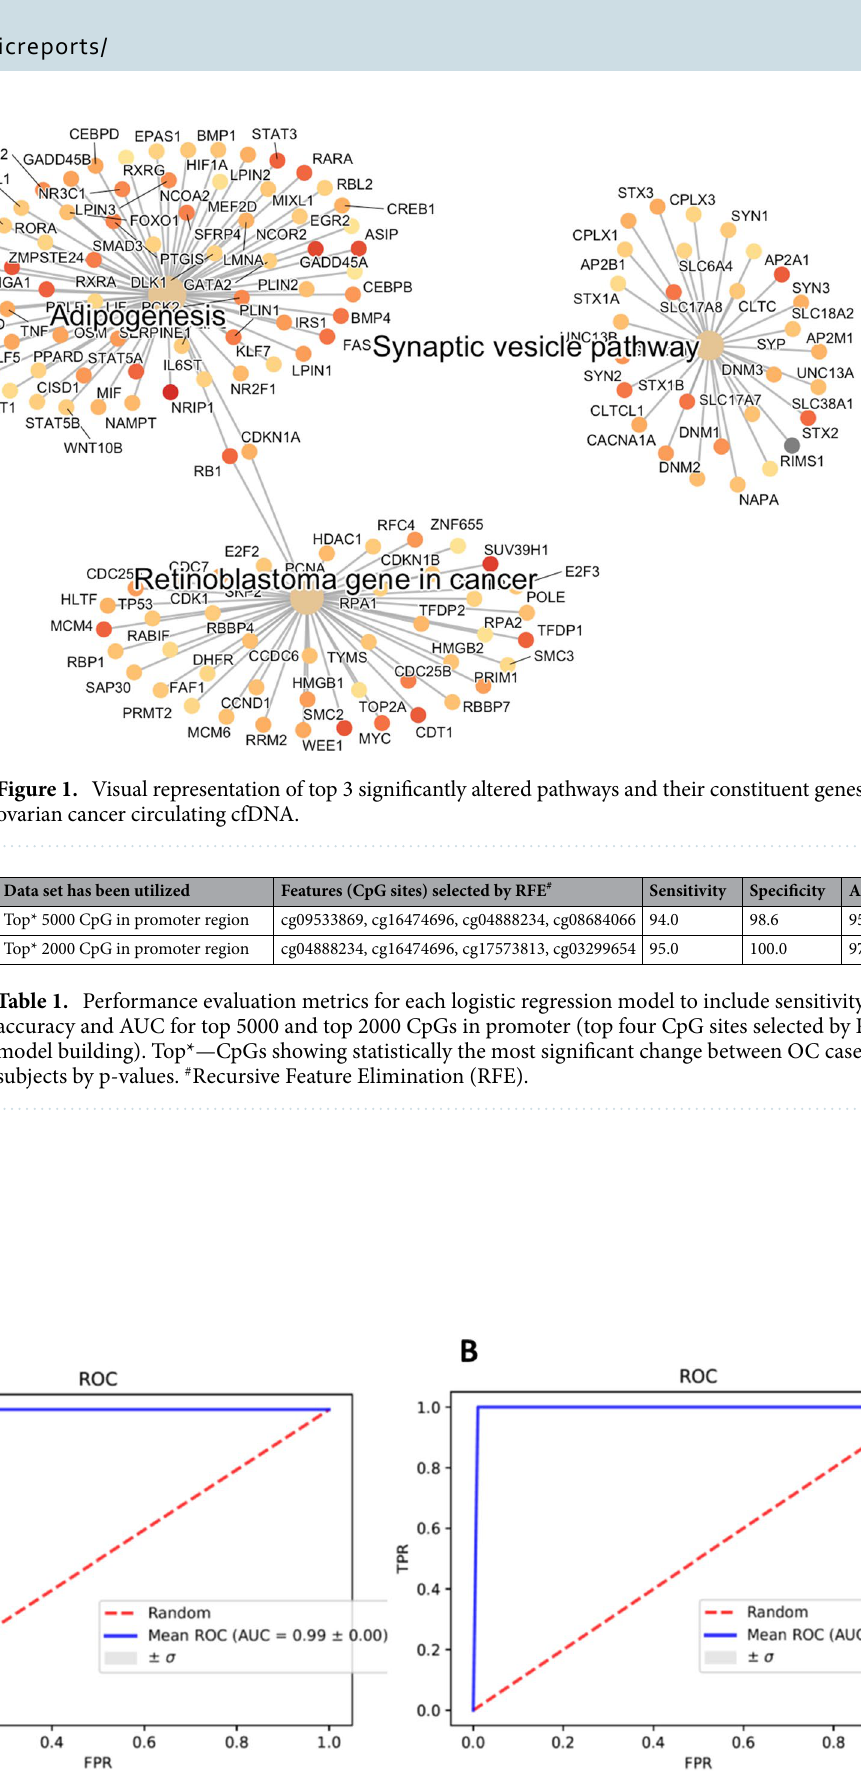
Figure 2. ROC curves provided by analyses of the top CpGs of promoter region- based on individual ability to detect OC ( A ) Top 5000 CpGs, and ( B ) top 2000 CpGs. TPR true positive rate, FPR false positive